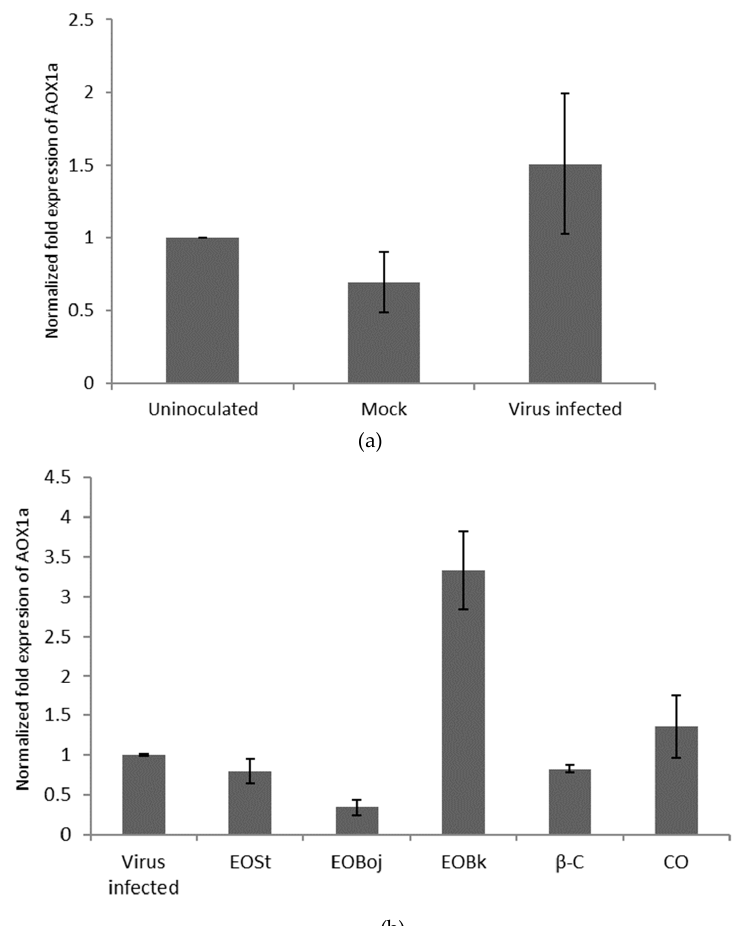
Figure 6. Relative expression of the alternative oxidase ( Aox1a ) gene in upper leaves of CMVsat infected Arabidopsis thaliana plants determined with qRT-PCR. Plants were: uninoculated, buffer-treated (Mock); infected with Cucumber mosaic virus containing associated satellite RNA (Virus infected); sprayed with essential oil (EO) of Micromeria croatica from the localities Bojinac (Boj), Ba č i ć kuk (Bk) and Stupa č inovo (St) or with β -caryophyllene ( β -C) and caryophyllene oxide (CO) three consecutive days prior to inoculation of the virus. Error bars represent standard deviation calculated from three biological replicates. Normalisation factors were calculated as the geometric mean of the expression levels of the reference genes (F-box and EF 1 α ). Uninoculated ( a ) or virus-infected ( b ) sample was used as the calibrator (=1). Leaves were harvested on the third day after inoculation. The asterisk (*) denotes a significant change in the expression of the Aox1a compared to the control ( p <